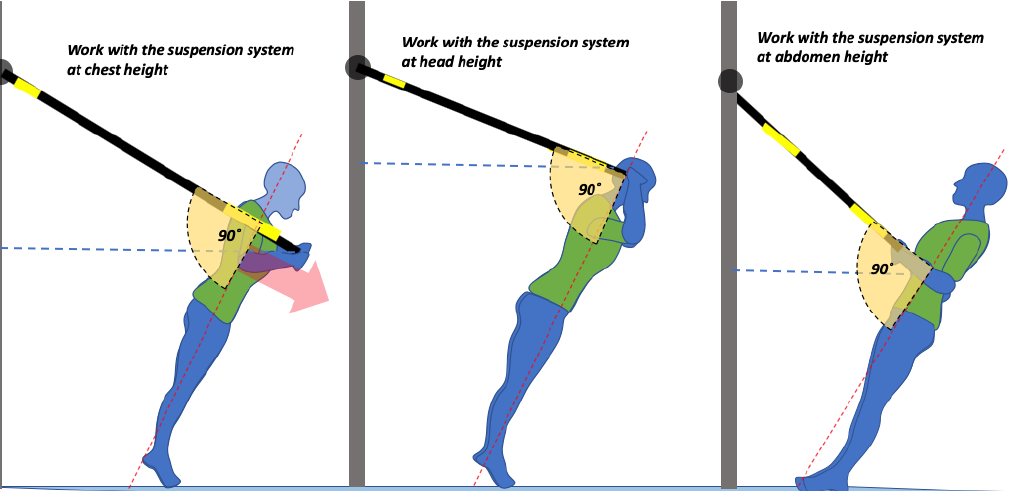
Figure 3. Different options for exercise positions.